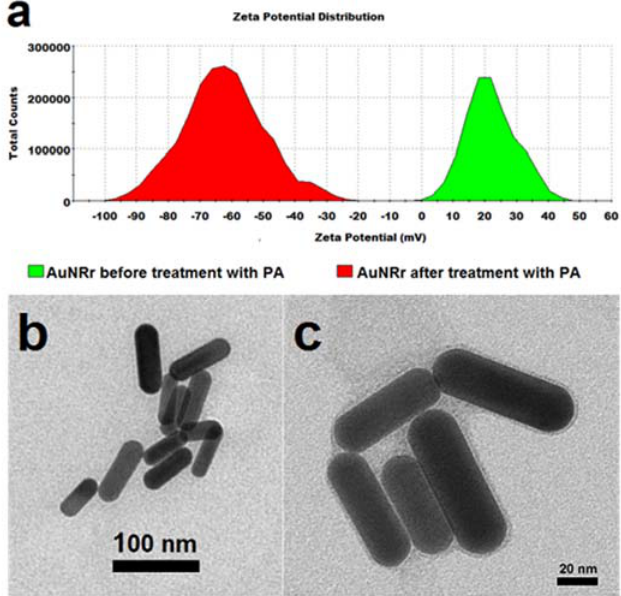
Figure 7. ( a ). Zeta potential measurements of AuNRs before (green) and after (red) treatment with L ‐ α‐ phosphatidic acid (PA). ( b ) Negative stained TEM of AuNRs after synthesis. ( c ) AuNRs after treatment with PA.